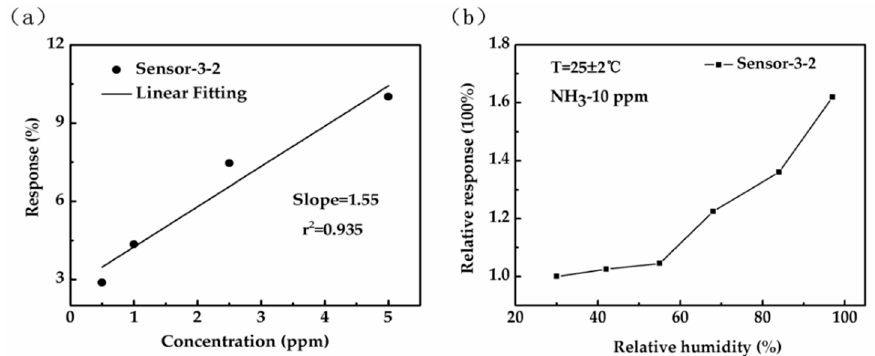
Figure 10. ( a ) Linear response with increase of ammonia concentration of Sensor-3-2; ( b ) relative response of Sensor-3-2 to 10 ppm ammonia under different relative humidity values.